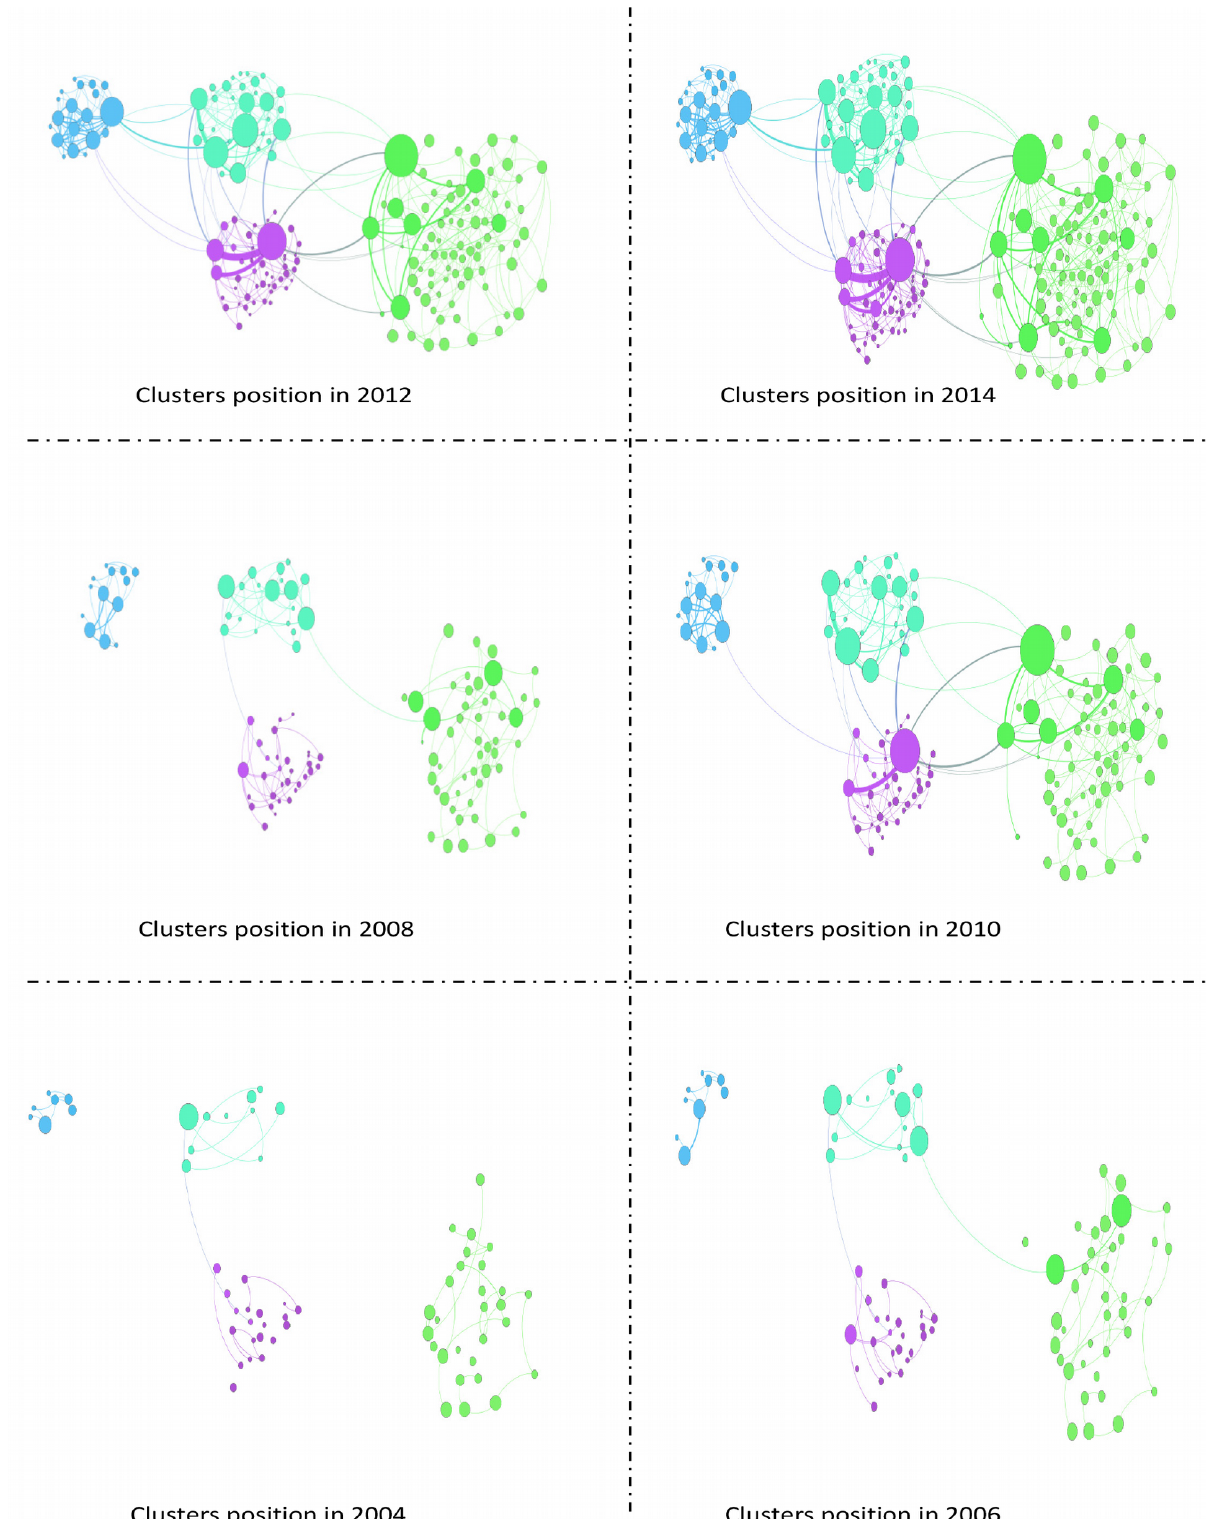
Figure 5. The evolution of clusters positions over